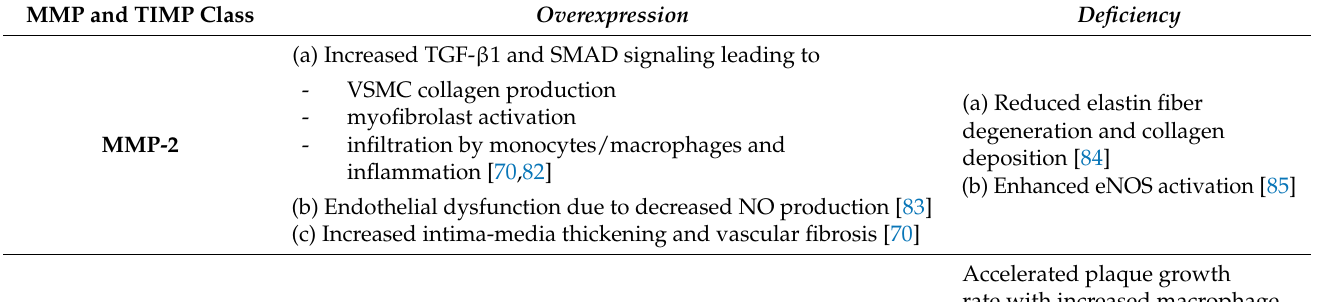
Table 1. Major matrix metalloproteinases along with their relative inhibitors and their involvement in vascular